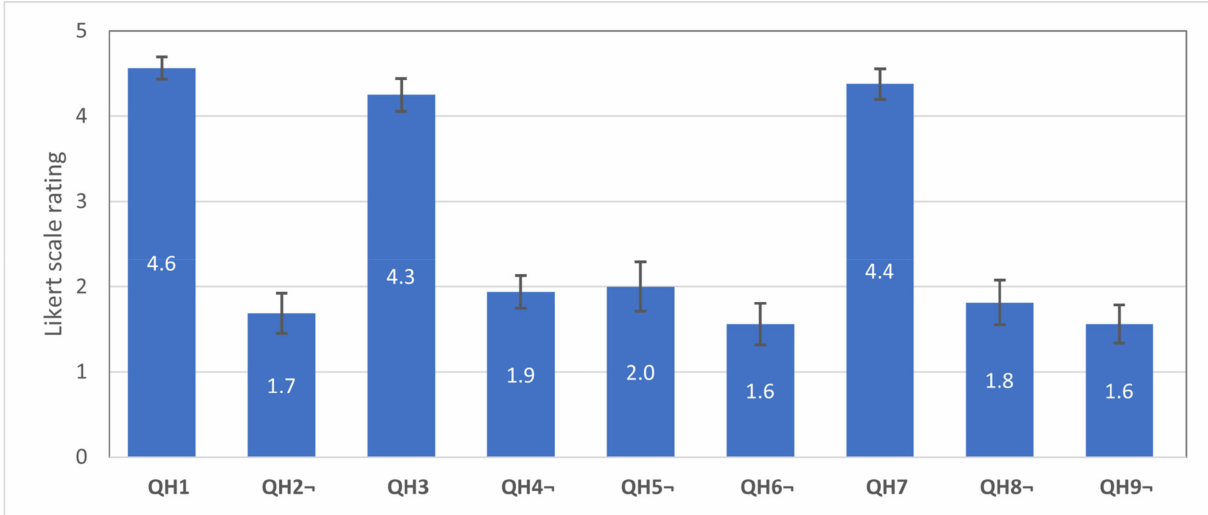
Figure 18. Average scores with standard errors for the questions QH1–QH9 used for evaluation of the HMI usability. Score 5 denotes “totally agree”, and 1—“totally disagree”. Questions QH1, QH3, QH7—higher is better; QH2, QH4, QH5, QH6, QH8, QH9—lower is